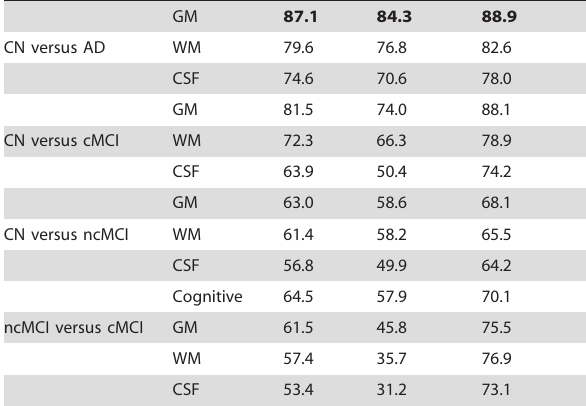
Table 3. Median values of classification accuracy, sensitivity and specificity across cognitive groups are presented.